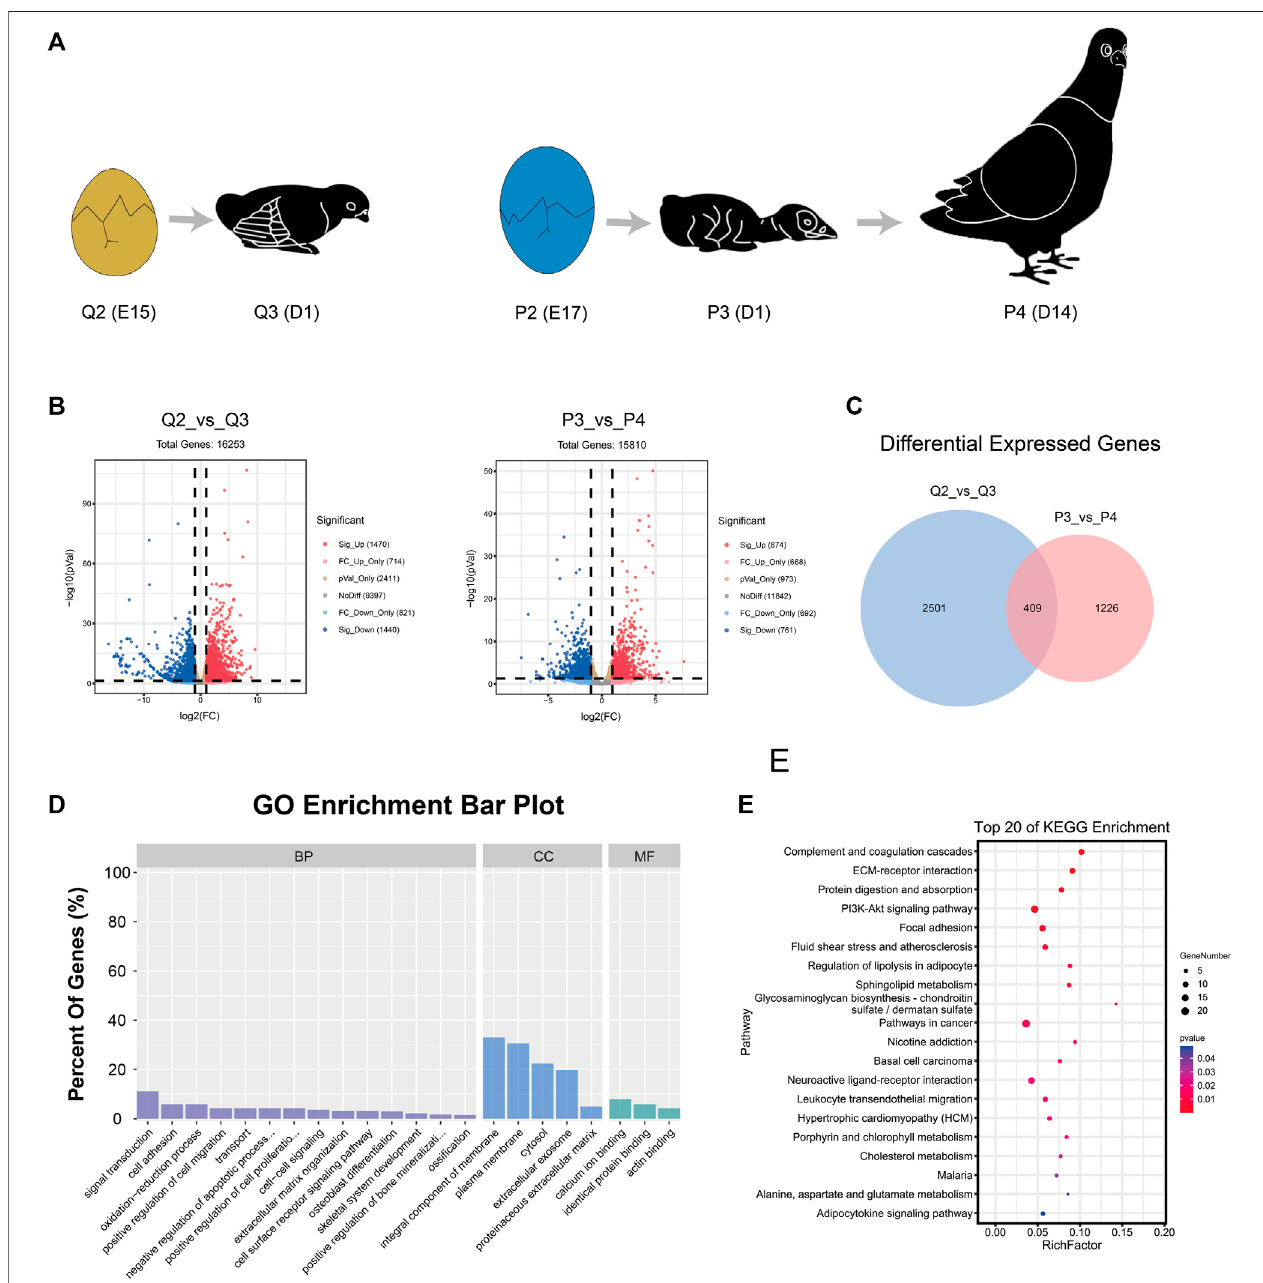
FIGURE 3 | Analysis of differential expression genes in quail and pigeon. (A) The time for quail and pigeon from being unable to stand to be able to stand. (B) VolcanoplotsofgenesingroupQ2vs.Q3andP3vs.P4. (C) ThecommonDEGsbetweenQ2vs.Q3andP3vs.P4. (D) GOenrichmentanalysisofthesharedDEGs. (E) KEGG pathway enrichment analysis of the shared DEGs. BP: biological process, CC: cellular component, MF: Molecular Function.